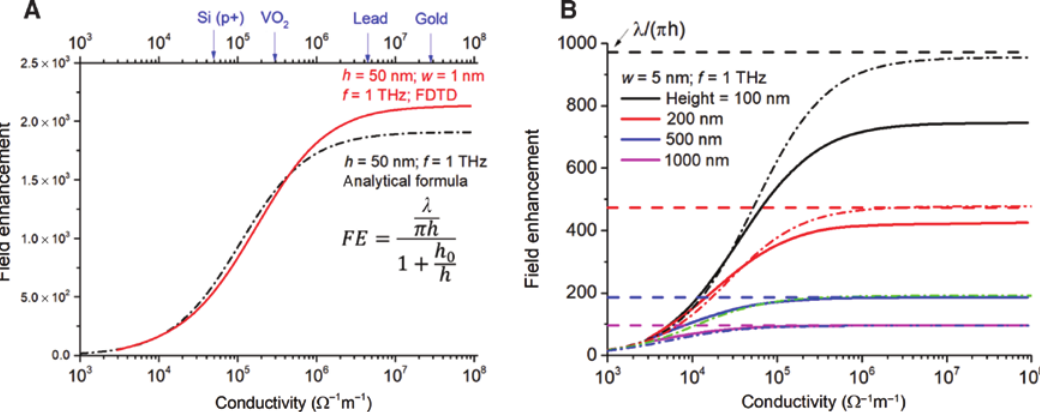
Figure 8: Field enhancement with varying conductivity of metal. (A) Field enhancement for a 1-nm-wide gap in 50-nm-hick film at 1 THz is plotted in terms of conductivity, calculated by FDTD and analytical formula. In particular, typical conductivities of a heavily doped Si (p + ), VO , lead, and gold cases are denoted in blue arrows. (B) Enhance- 2 ment factors for 5-nm-wide gaps in several films with thickness of 100, 200, 500, and 1000 nm at 1 THz are plotted in terms of